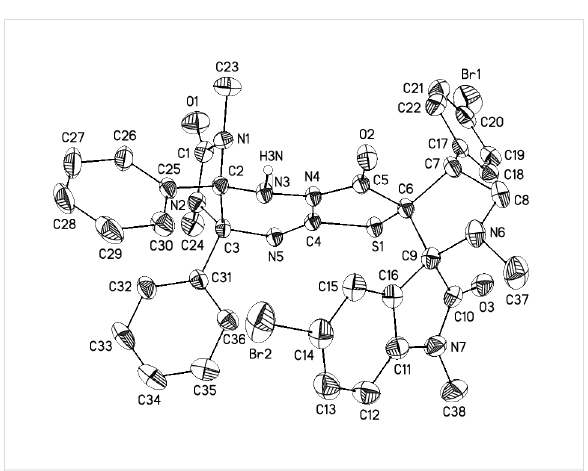
Figure 6: General view of 4e in the crystal in thermal ellipsoids repre- sentation (40% probability). Hydrogen atoms connected to carbon atoms are omitted for